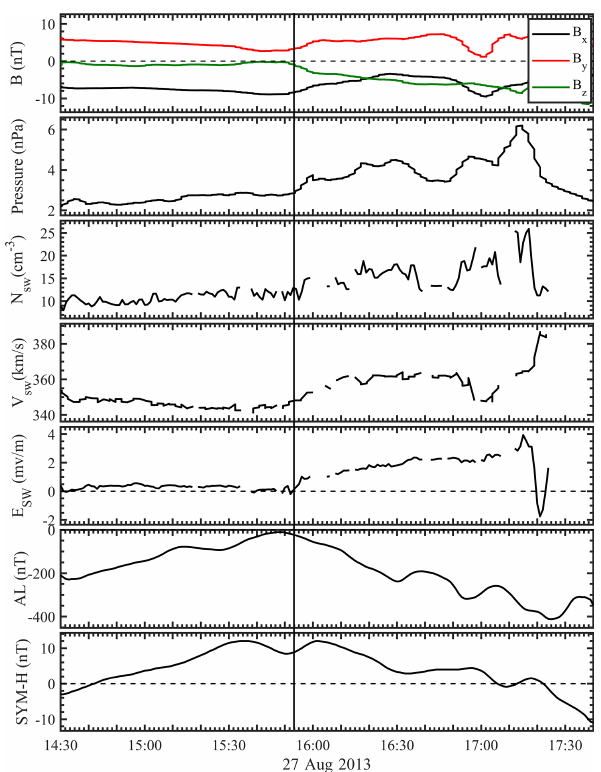
Figure 1. Solar wind and geomagnetic parameters from 14:30 to 17:40UT on 27 August 2013. (a) Three components of IMF in GSM coordinates. (b) Solar wind dynamic pressure, (c) proton den- sity, (d) solar wind velocity, and (e) convection electric field of solar wind. (f) AL index and (g) SYM-H index. The vertical line indicates the time when the solar wind convection electric field started to in-